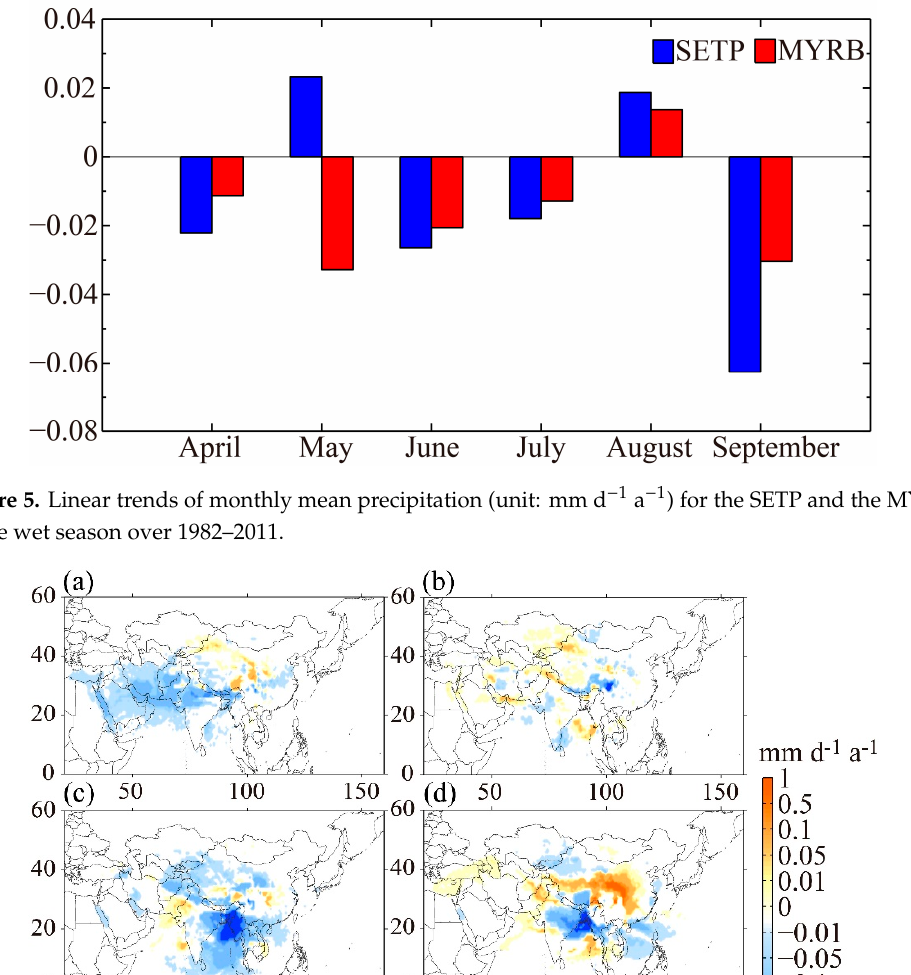
Figure 5. Linear trends of monthly mean precipitation (unit: mm d -1 a -1 ) for the SETP and the MYRB in the wet season over 1982–2011.